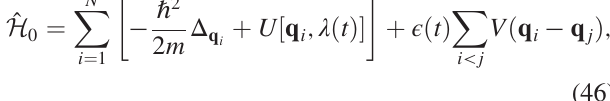
Fig. 1. The dashed lines represent the adiabatic energy shells corresponding to H 0 for a particular energy E . Notice